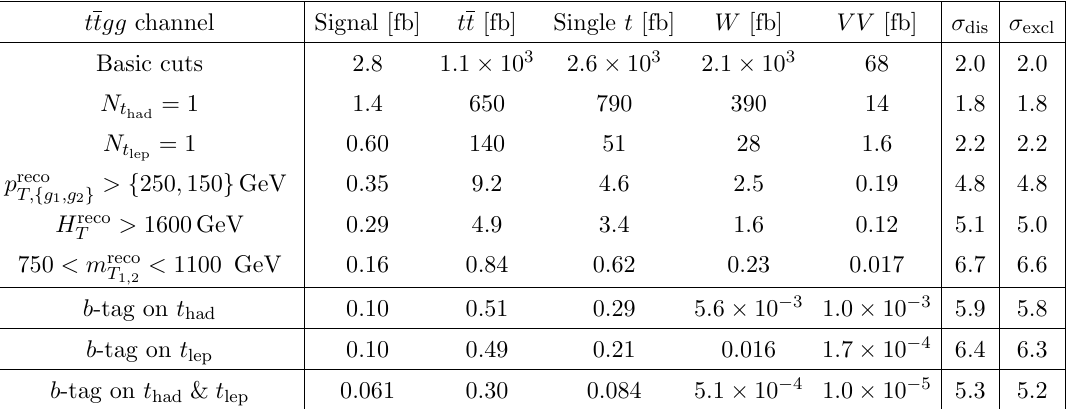
Table 2 . A cumulative cut-(cid:13)ow table showing the signal and SM background cross sections in the ttgg channel for m T = 1 : 0 TeV. The signi(cid:12)cances (cid:27) dis and (cid:27) excl are calculated based on the likelihood-ratio methods de(cid:12)ned in eq. (4.22) and eq. (4.24) respectively for a given luminosity of 3 ab (cid:0) 1 . The summary of the background simulations can be found in table 1. be simply reconstructed since the initial state longitudinal momentum is unknown.